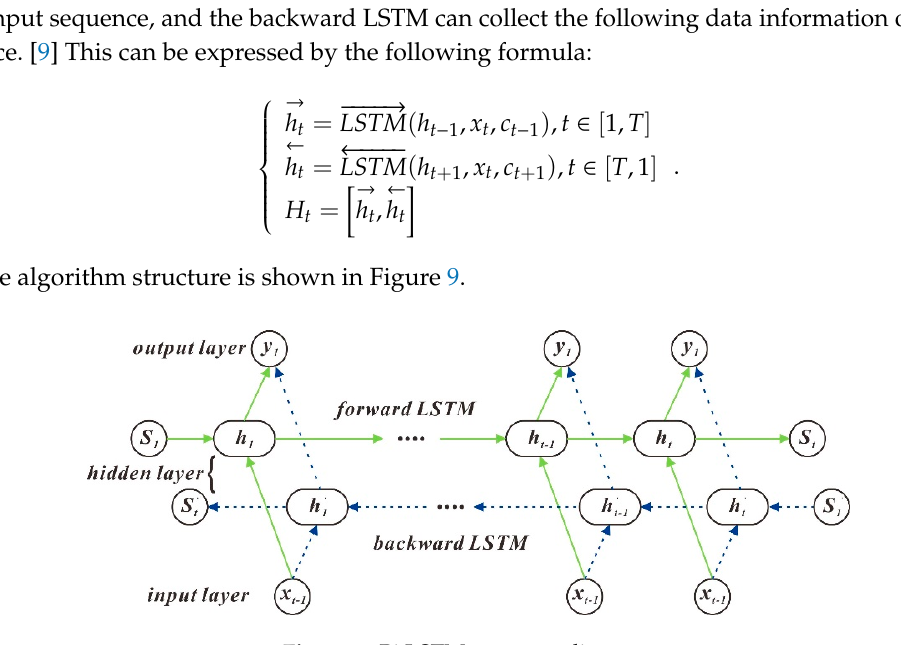
Figure 10. Stacked Autoencoder (SAE) structure diagram. Table 5 shows the computer configuration. Table 5. Computer configuration. Name